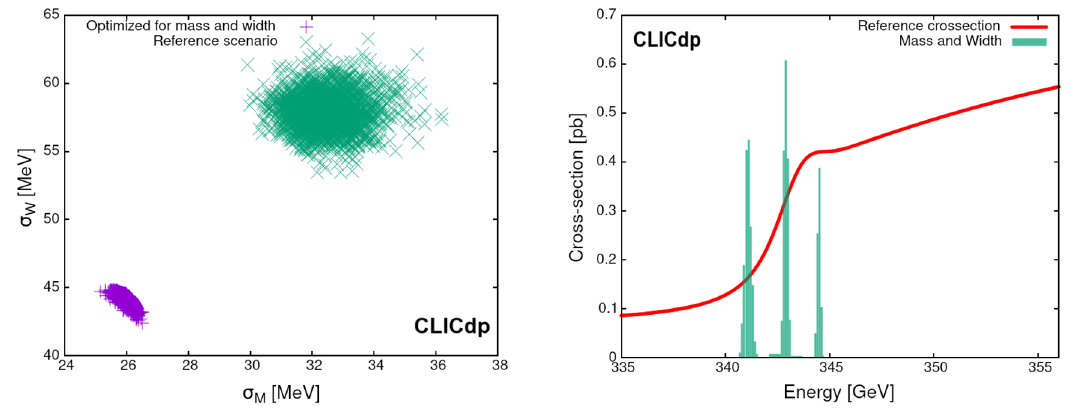
Figure 11 . Left: mass and width uncertainty distribution in the first (green) and the last (blue) generation for scan optimised for both mass and width determination precision. Right: distribution of the measurement points from the last generation (arbitrary scale) compared with the reference cross section